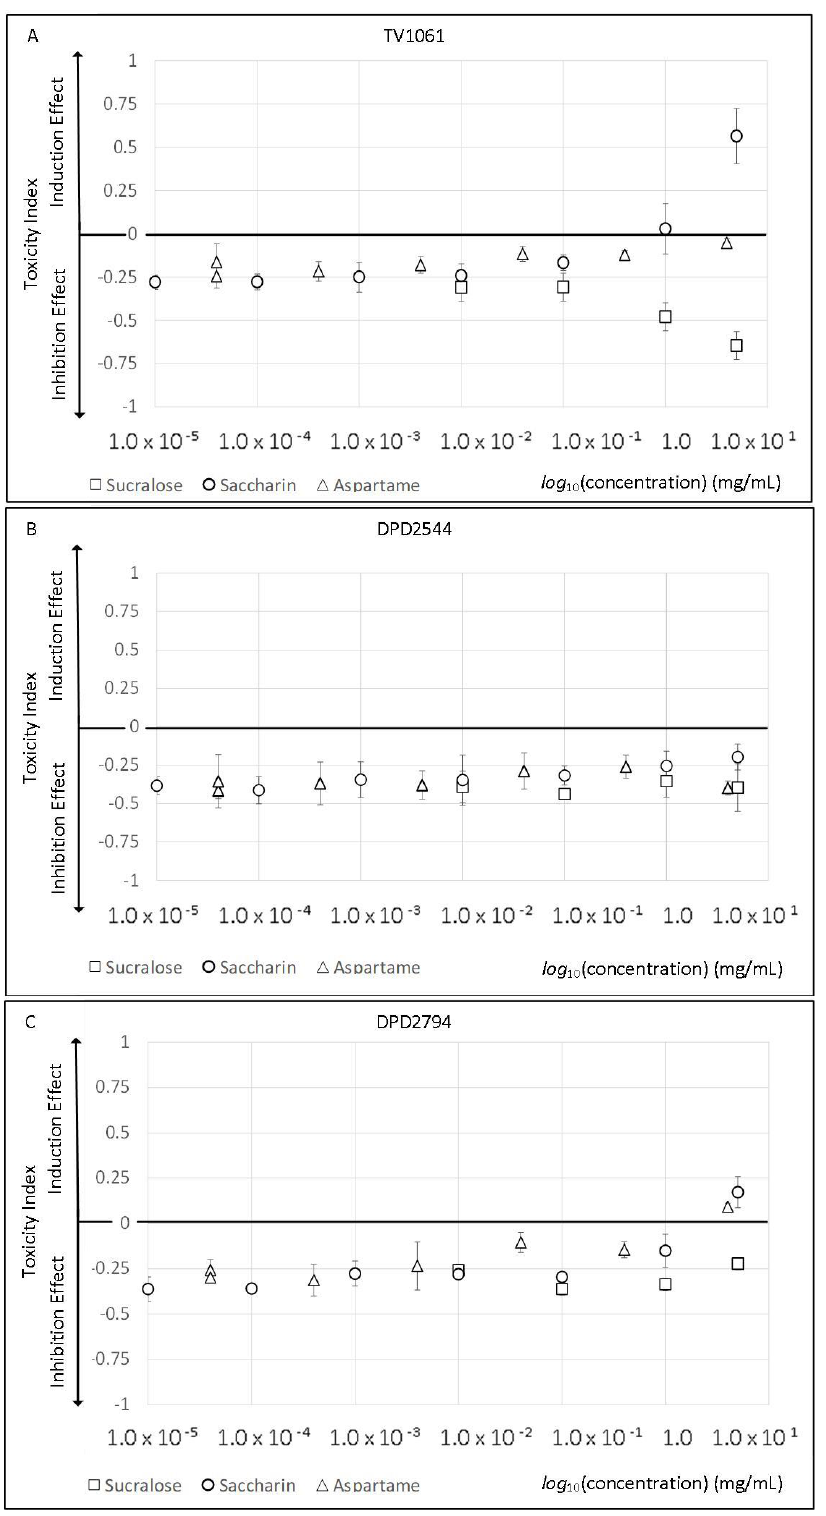
Figure 1. Artificial sweeteners toxicity. The toxicity index of different artificial sweeteners on the three tested bioluminescent bacteria strains: ( A ) TV1061; ( B ) DPD2544; ( C ) DPD2794. A strong induction response pattern may be observed in the response of the TV1061 strain to saccharin and